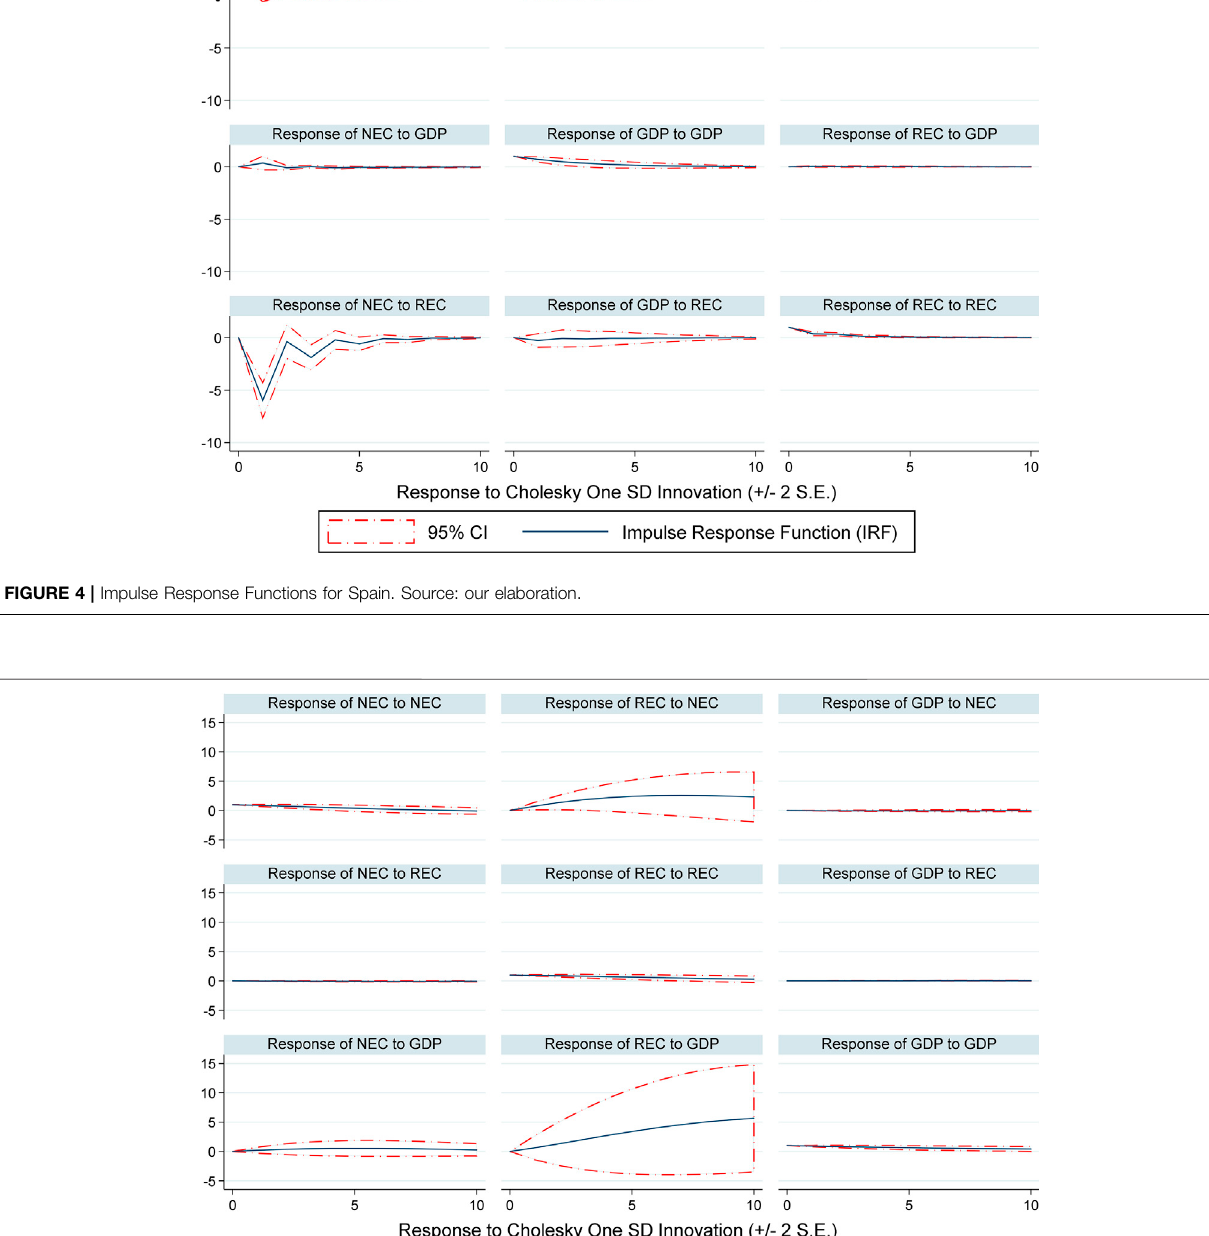
Frontiers in Environmental Science |